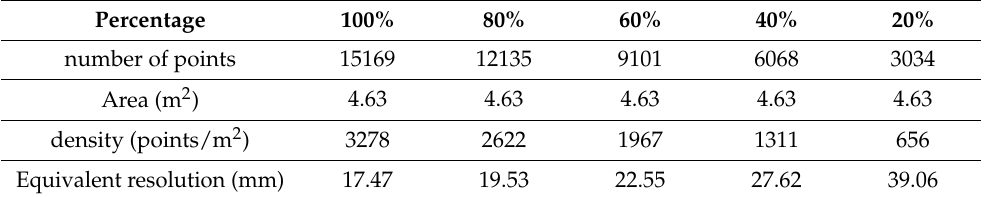
Table 4. Resolution of extracted point